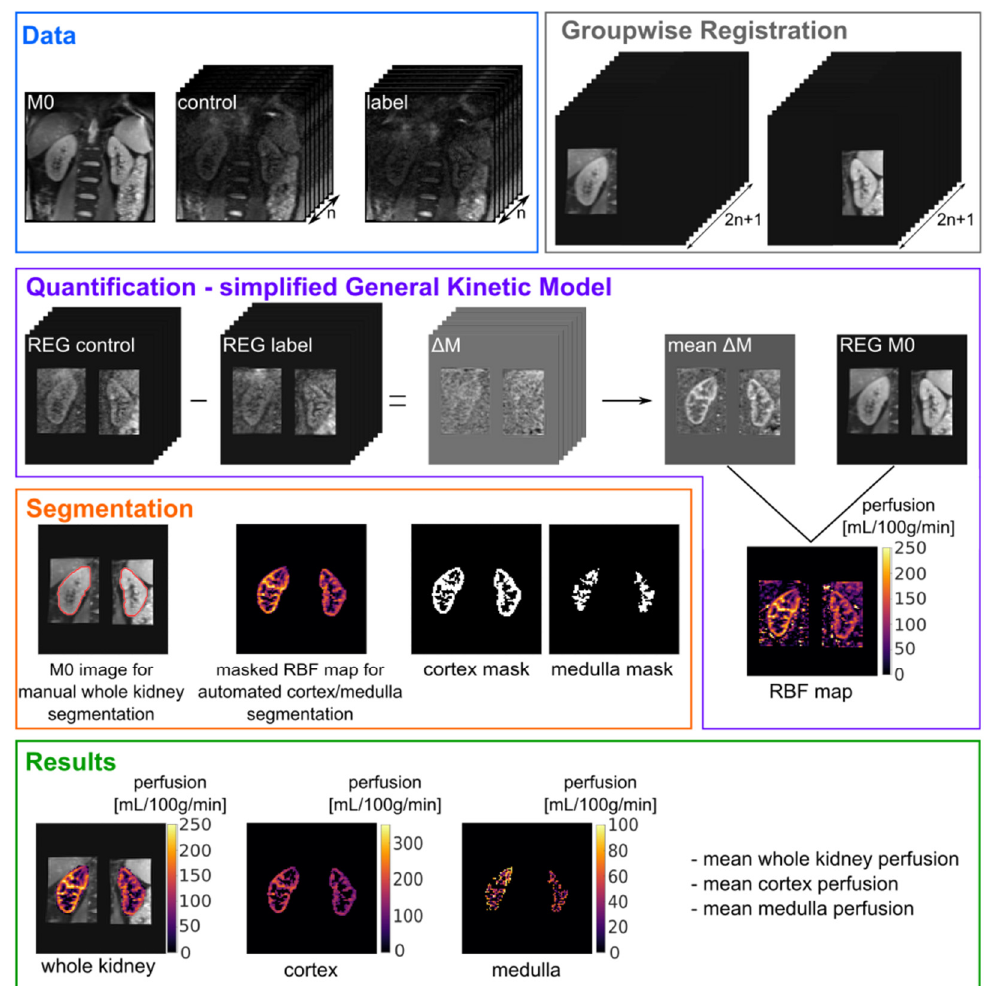
Figure A1. Flowchart of the processing pipeline. The ASL data, consisting of one M0 image, n control images, and n labeled images, is first registered using a groupwise registration strategy. The registered control and labeled images are then subtracted and averaged to obtain a mean perfusion-weighted image ∆ M. RBF is quantified with the general kinetic model. For the segmentation, the kidney contour is first manually drawn for each kidney. The obtained whole kidney masks are applied on the RBF map and a k-means clustering algorithm is employed for cortex/medulla segmentation. The final results are RBF maps of the whole kidneys, cortex, and medulla, as well as mean RBF values for each. Abbreviations used: n—number of control-label pairs acquired; REG—registered; RBF—renal blood flow.